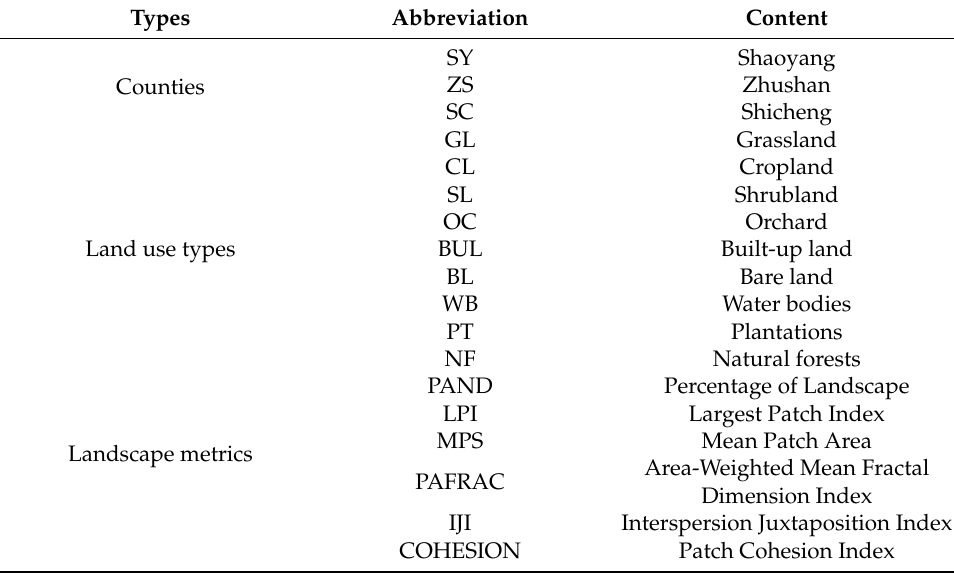
Table A1. Counties, land use types, and landscape metrics